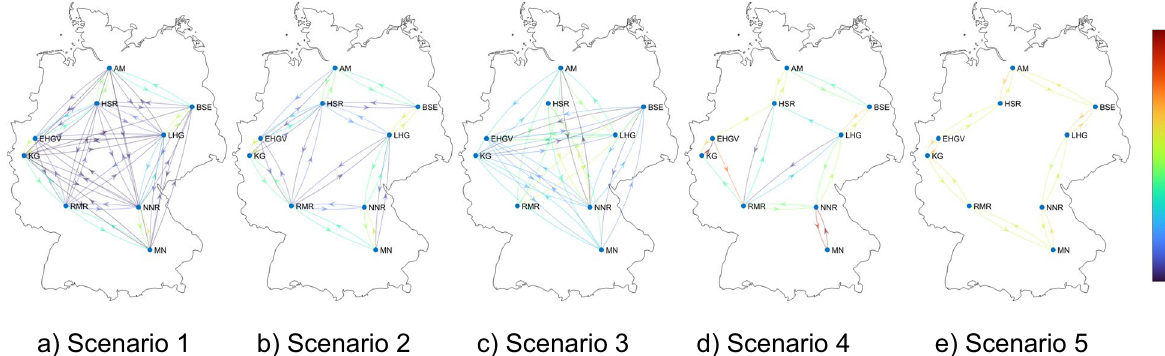
Fig. 2 Colour-weighted mean number of trains on each arc for each Scenario (test series i))